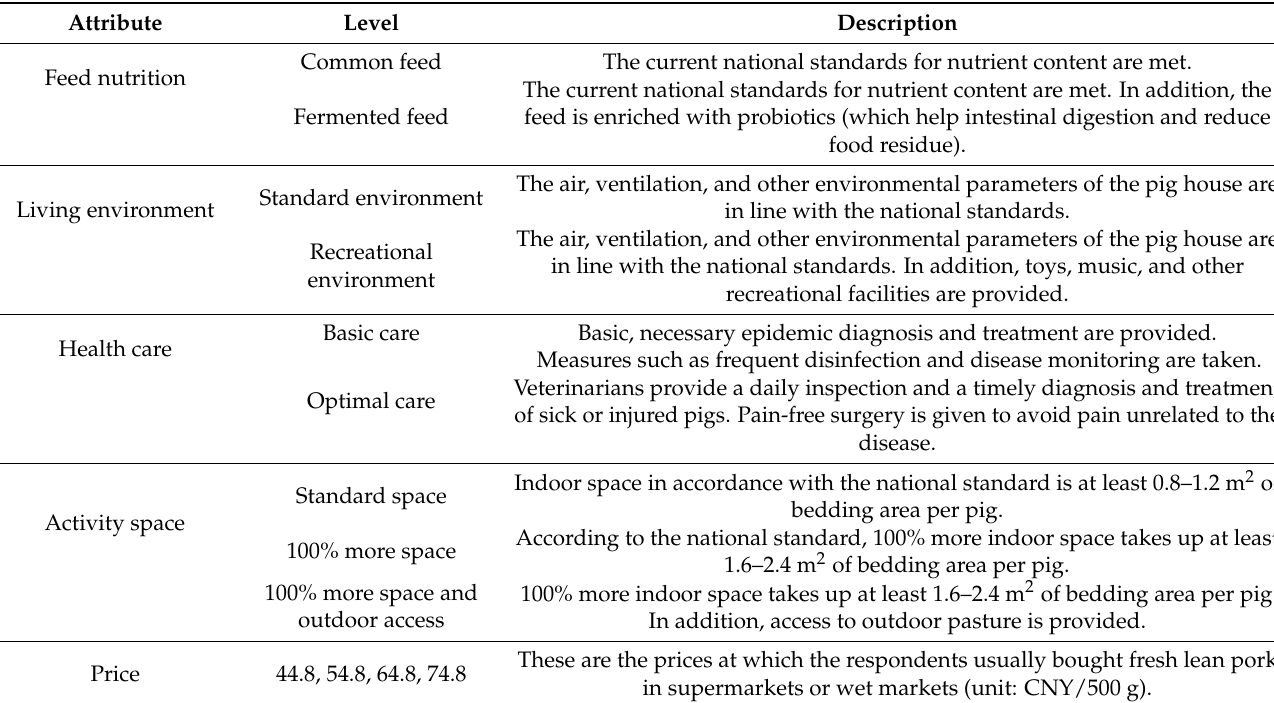
Table 1. Farm animal welfare attributes and their levels in the choice